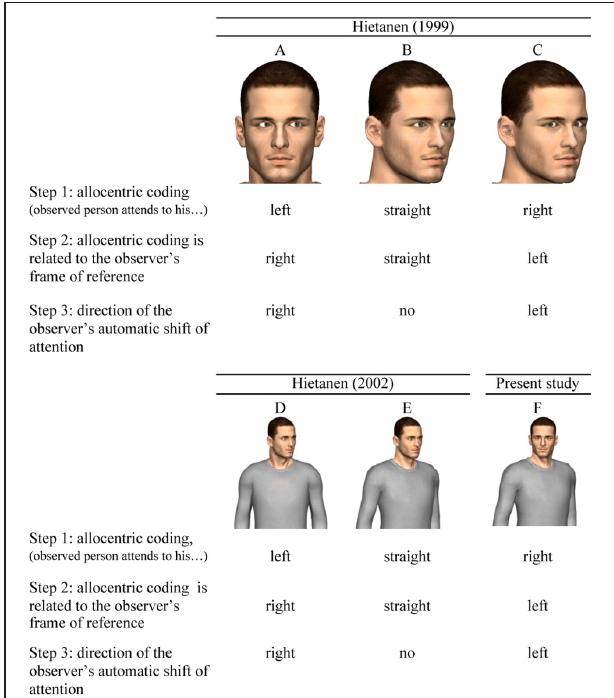
FIGURE 1 | Automatic attention shifts based on referential coding of body parts in an allocentric-based frame of reference. (A) frontal head with gaze averted, (B) lateral head with straight gaze in the same direction, (C) lateral head with gaze toward observer, (D) frontal body with head averted, (E) sideways body with head in the same direction, and (F) sideways body with head facing the